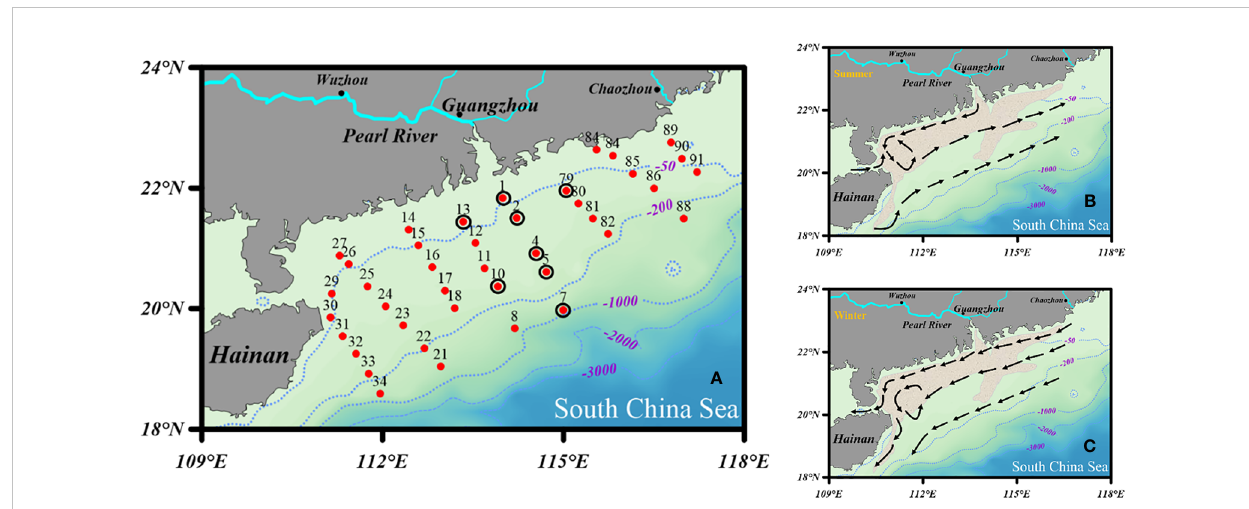
FIGURE 1 Sampling sites and patterns of surface coastal currents in (B) summer and (C) winter [modi fi ed from Wei et al. (2020)]. The khaki-shaded area represents the distribution of the Pearl River-derived mud belt based on Ge et al. (2014). The sediment samples were collected in April 2014. The red dots (*) and black circles ( ○ ) in (A) represent the grid stations and sediment locations for the fl ow-through